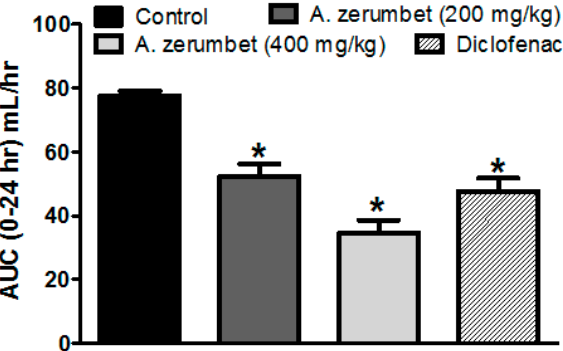
Figure 5. Effect of treatment with two dose levels (200 and 400 mg/kg, p.o.) of A. zerumbet or the reference standard, diclofenac (20 mg/kg, p.o.), on carrageenan-induced (1% suspension, 0.1 mL/rat) hind paw edema in rats. Edema thickness (mm) was measured before and every hour for 5 h, and at 24 h after carrageenan injection. Results represent the AUC 0-24 after 24 h and are expressed as mean ± S.E.M. (n = 5). * p < 0.001 vs. control